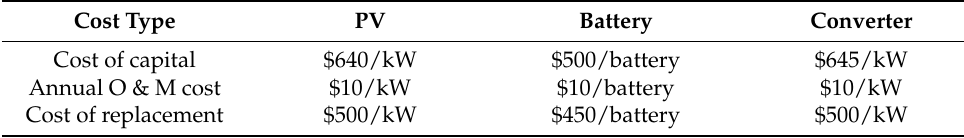
Table 2. Financial cost values of the components.